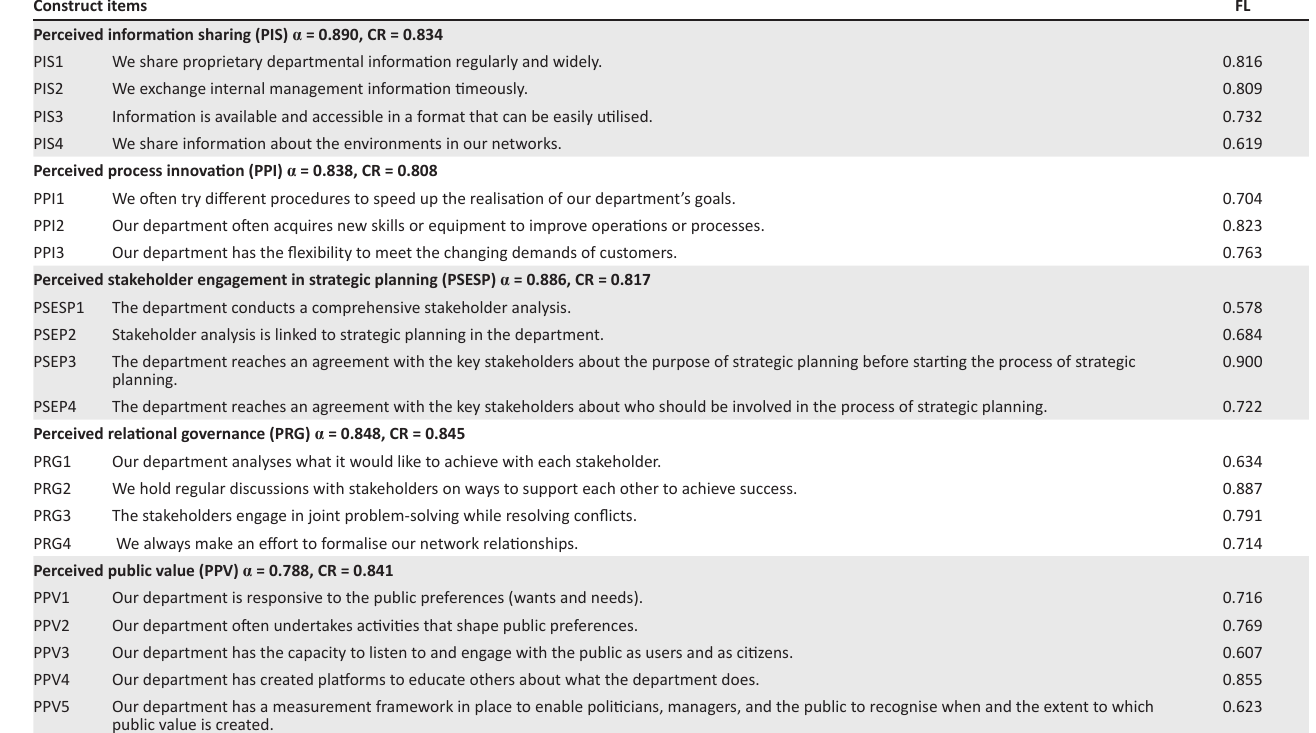
TABLE 3: Validity and reliability assessments. Construct